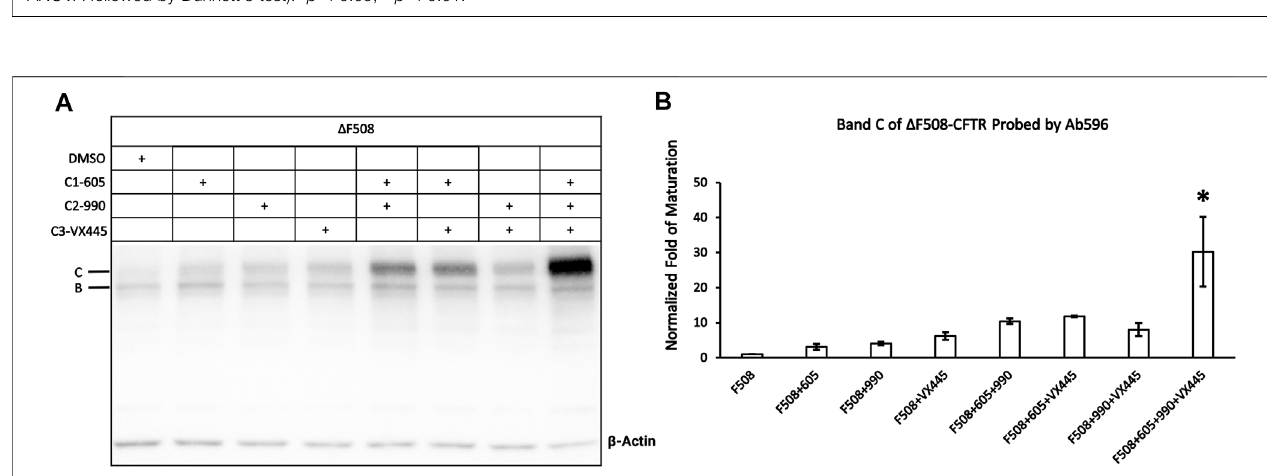
FIGURE 6 | Western blot analysis of the expression of the Δ F508-CFTR. (A) Effects of type 1 (605), 2 (990), and 3 (VX-445) of CFTR correctors on Δ F508-CFTR expression. Gel was probed with antibody 596. (B) Quanti fi cation of the expression of the mature Δ F508-CFTR under different treatments compared to Δ F508 treated with DMSO. Data are represented as mean ± SEM. (N = 3, ANOVA followed by Tukey ’ s test). Triple combinations of C1-605, C2-990 and C3-VX445 have a signi fi cant increase compared to all other groups. * p < 0.05.